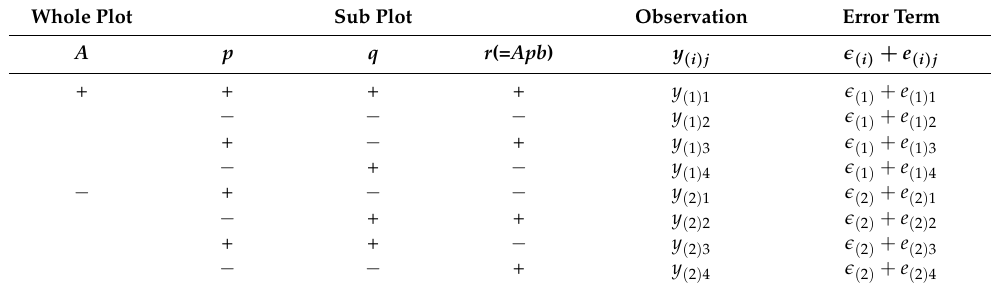
Table 5. The runs of D 1 . Whole Plot Sub Plot Observation Error Term